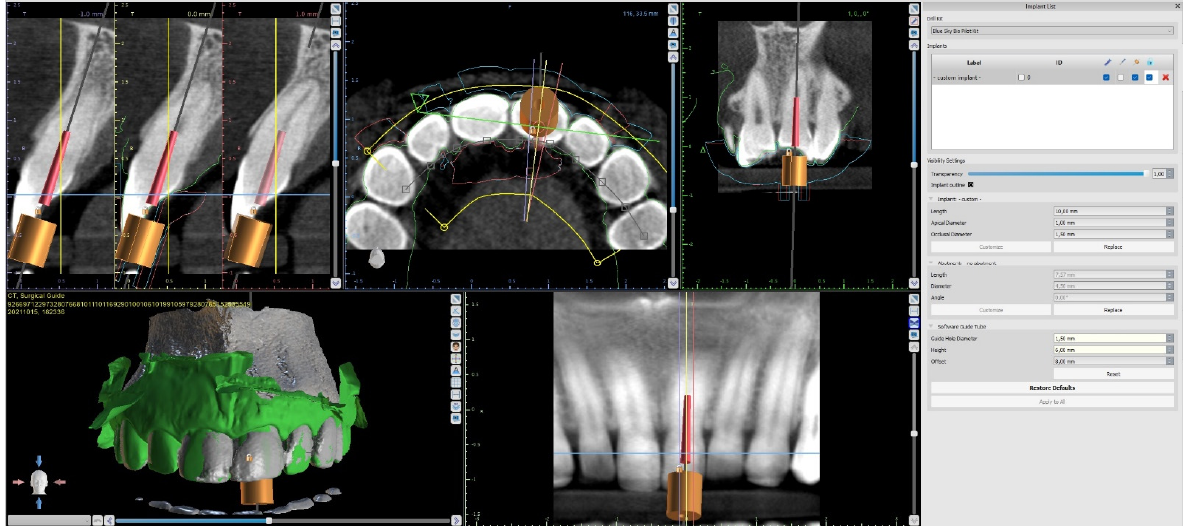
Figure 10. Figure presenting settings of custom implant in Blue Sky Plan software. Implant length, guide tube height, and offset must be equal to access tool’s working length.